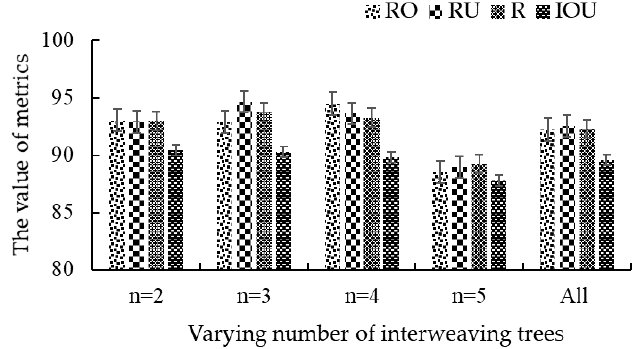
Figure 17. Segmentation results of multiple interweaving trees based on the proposed method. n represents the number of fruit trees in the area.